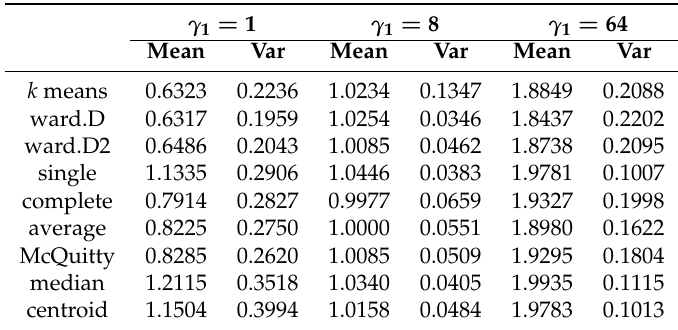
Table 2. Means and variances of simulated VIs using various clustering methods in the second stage of WNACut for γ 1 = 1, γ 1 = 8 and γ 1 = 64, respectively.